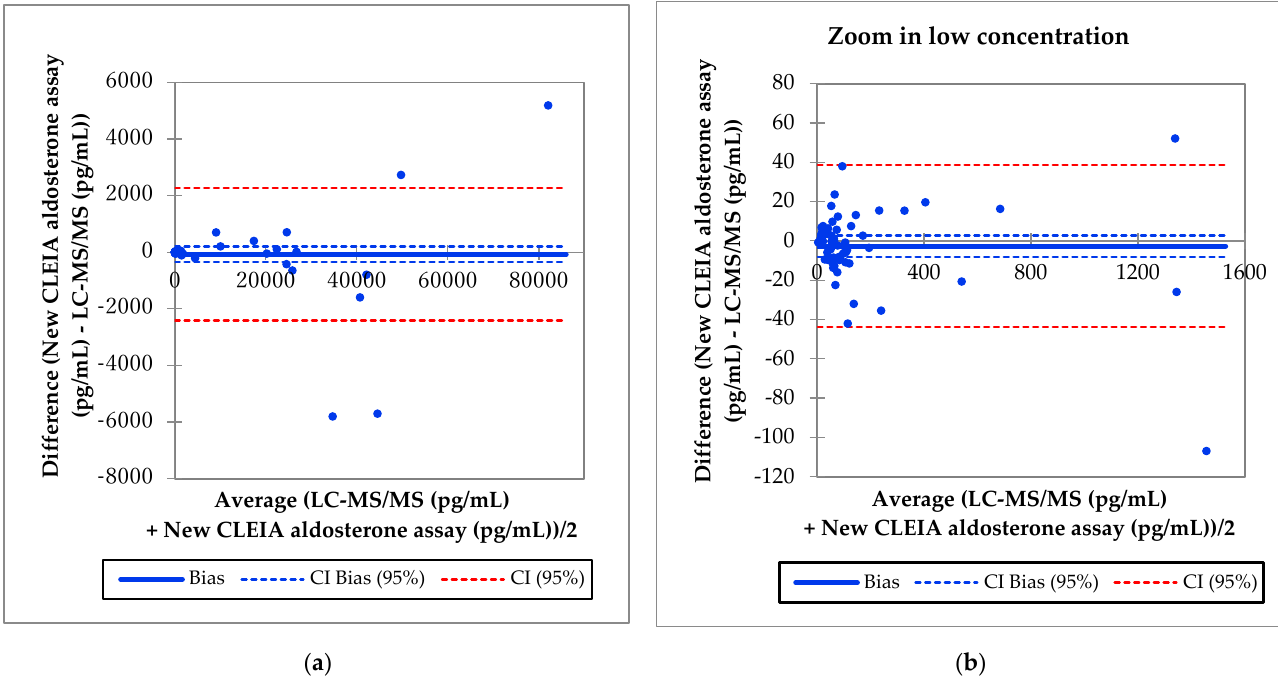
Figure 3. Bland-Altman results. ( a ) Aldosterone concentrations measured using the new CLEIA assay versus LC-MS/MS; ( b ) aldosterone concentrations measured using the new CLEIA assay versus LC-MS/MS in a concentration range of up to 1600 pg/mL.